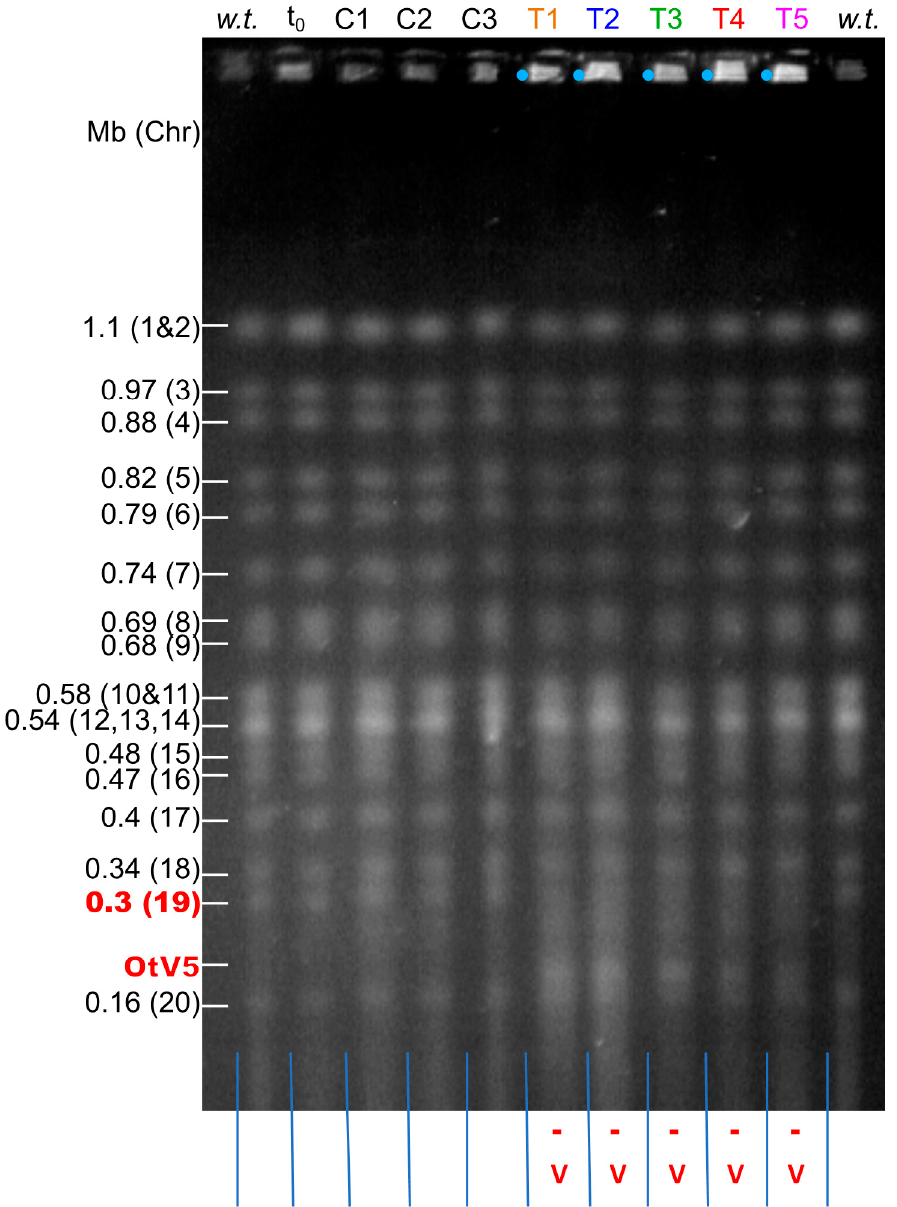
Figure 2. Karyotypes of O. tauri cultures visualised by pulsed field gel electrophoresis (PFGE) separation of the chromosomes. The sizes and positions of O. tauri chromosomes are indicated on the left. Chromosome 19 (red numbers) was not visualised in freshly OtV5-resistant test cultures (gel tracks indicated with red annotations at the bottom). w.t . : wild-type O. tauri RCC4221 from the original culture used before inoculation. t 0 : wild-type O. tauri RCC4221 from the RCC4221 culture at the start of the experiment. C1 , C2 and C3 : mock-inoculated Control cultures at 8 days post-inoculation (dpi). T1–T5 : Test cultures inoculated with OtV5 at MOI 5 (colours correspond with those in Figure 3 below), 8 dpi. - : absence of chromosome 19 at its expected mobility (312 kb) in test cultures. v : presence of the OtV5 viral genome (184 kb long) in inoculated cultures. Blue dots : wells with higher fluorescence.